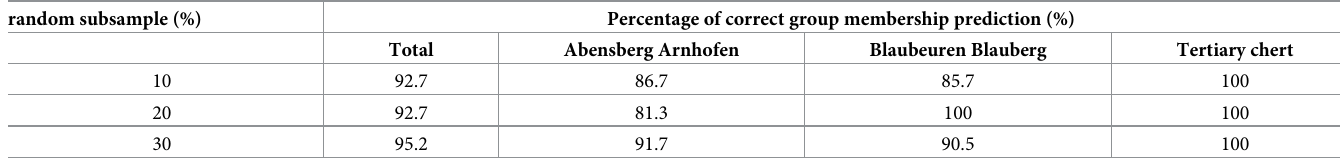
Table 4. Summary of the LDA accuracy tests. random subsample